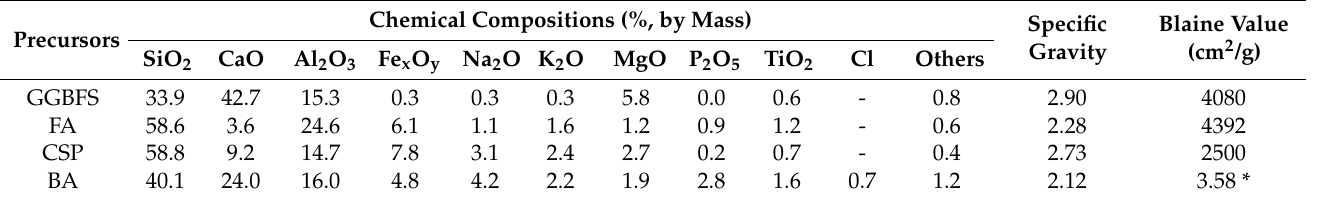
Table 1. Chemical compositions and physical properties of the precursors used.